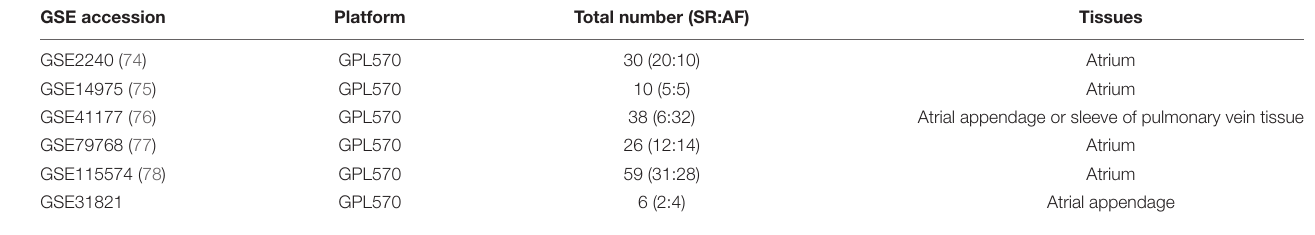
TABLE 1 | Summary of the six expression datasets involved in this